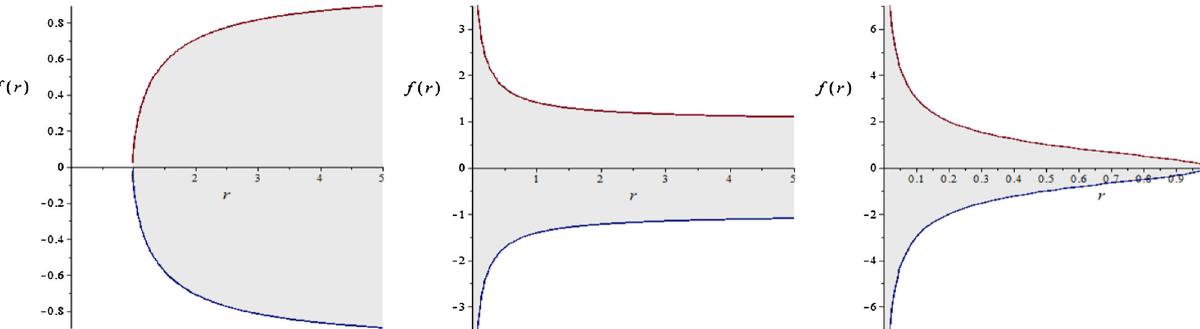
> 0 and C < 0. On center, 0 1